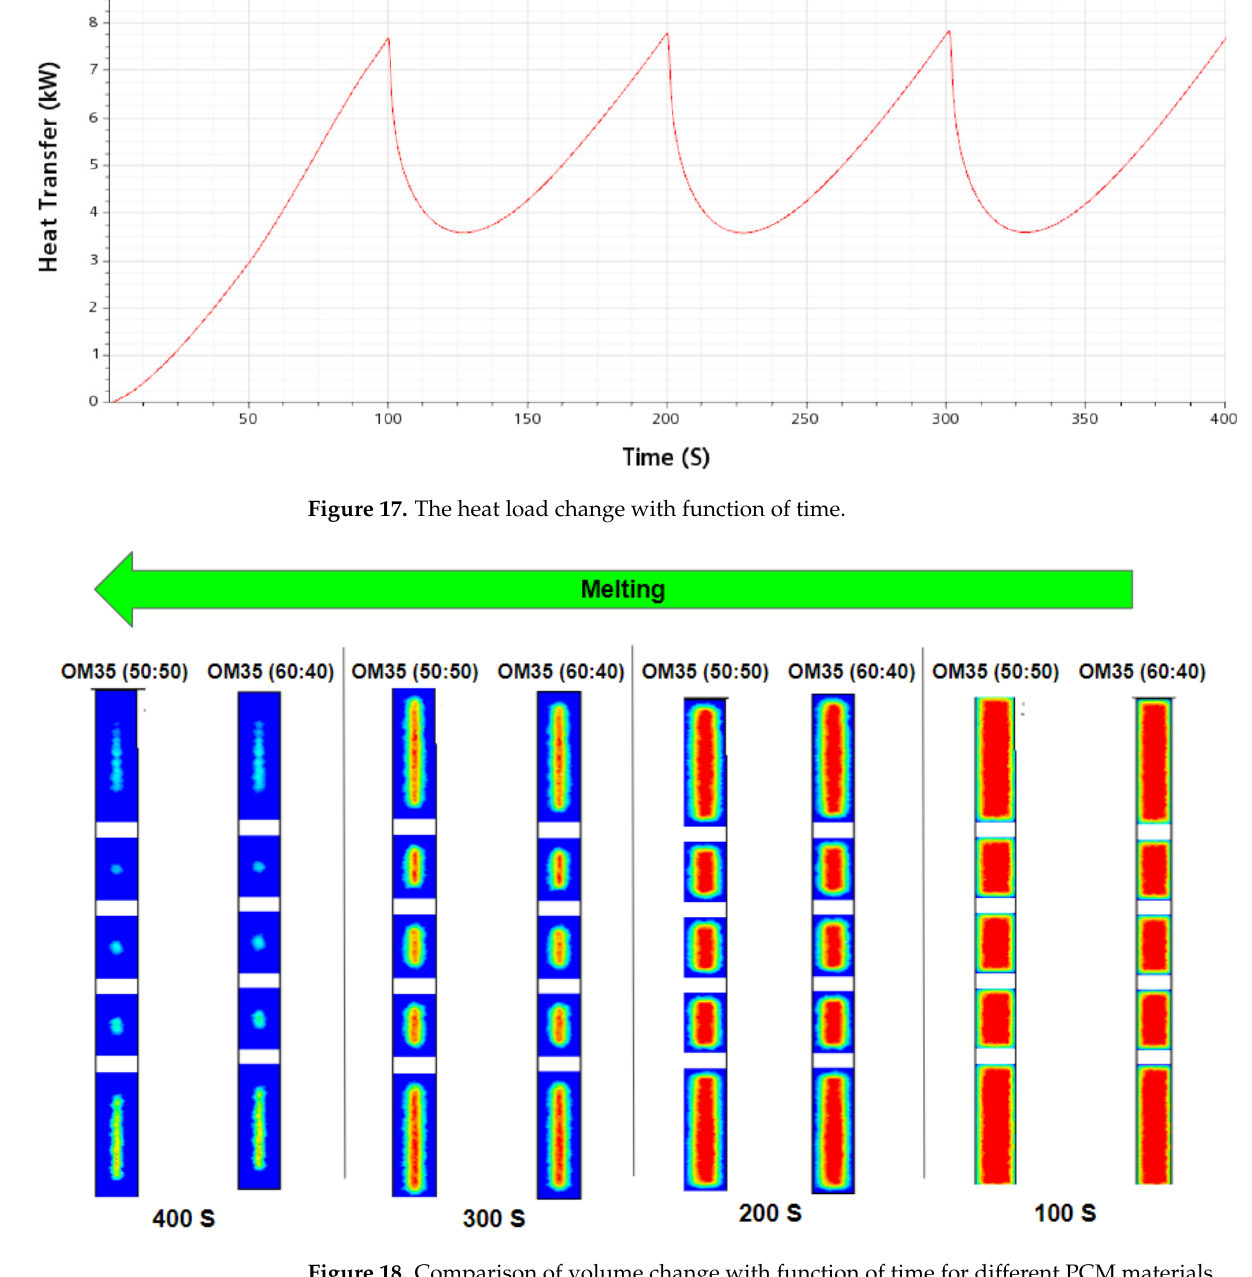
Figure 18. Comparison of volume change with function of time for different PCM materials.